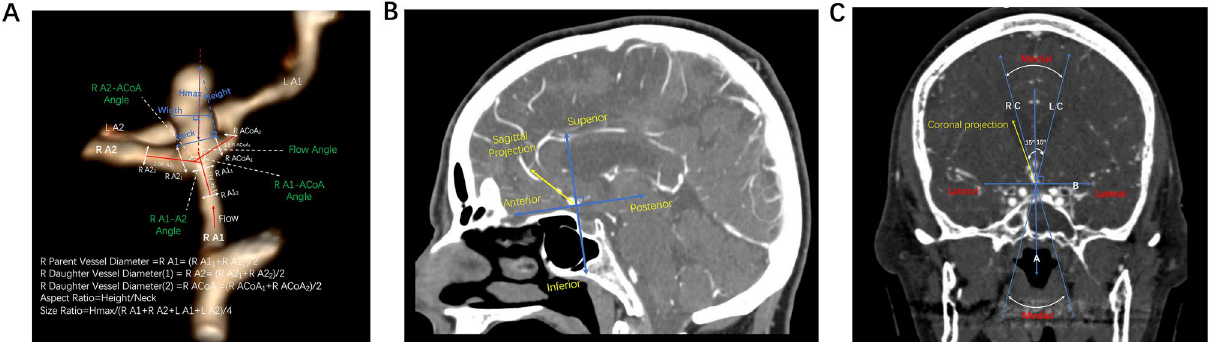
Figure 1. ( A ) Illustration of morphological parameters for anterior communicating artery (ACoA) aneurysm. ( B ) Projection of ACoA aneurysm based on sagittal view. Horizontal line is parallel to the anterior skull base. ( C ) Location of ACoA aneurysm based on coronal projections. Medial location is defined as projections within 15° of midline, between lines RC and LC. Image was partially created by Vitrea Advanced Visualization software (version